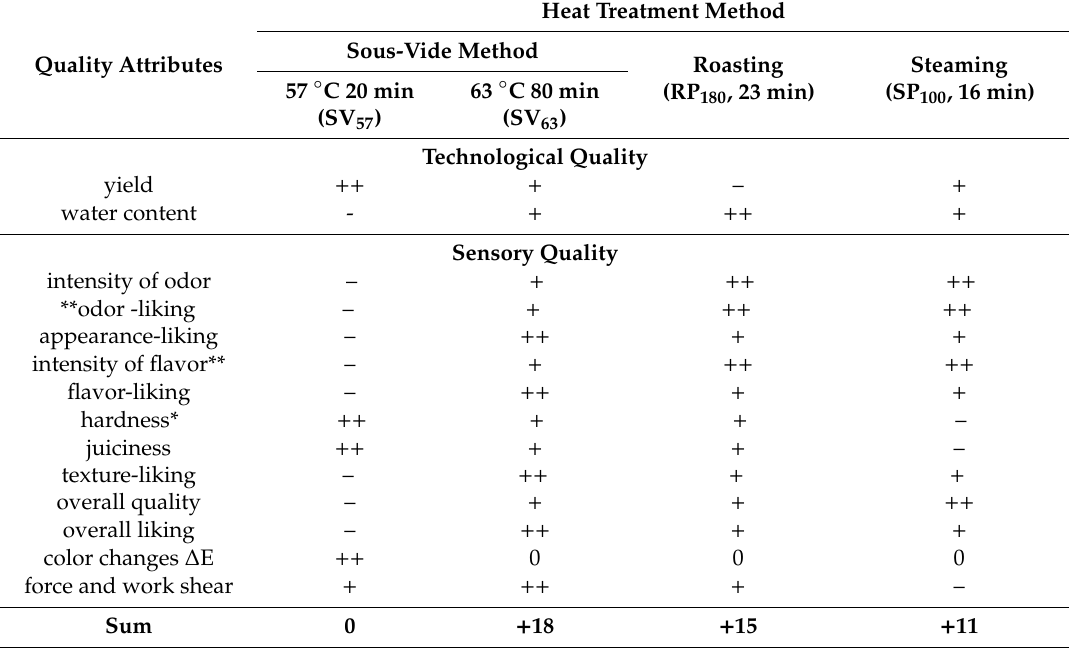
Table 7. Salmon quality changes depending on the cooking